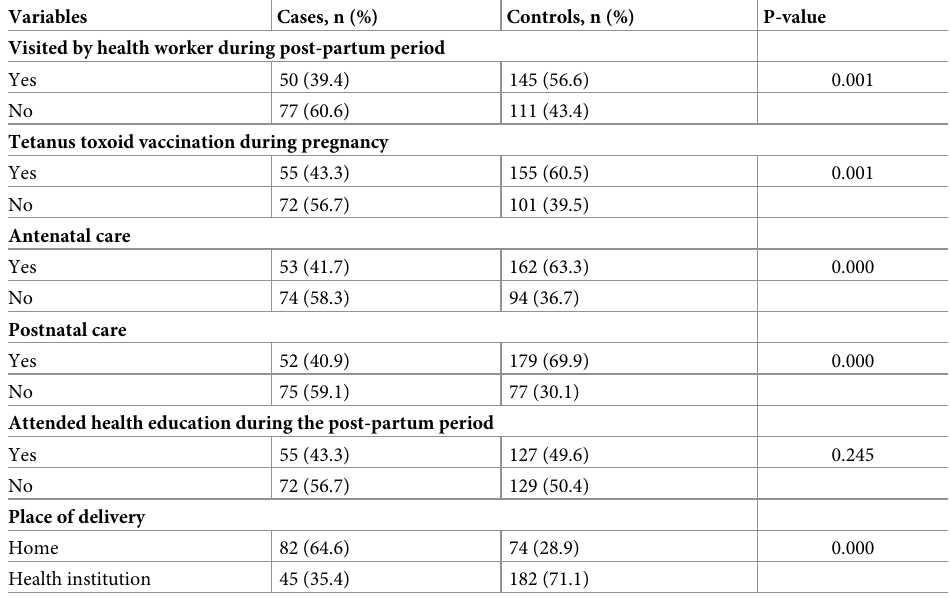
Table 3. Maternal continuum care characteristics mothers in Dabat district, Northwest, Ethiopia, 2021.